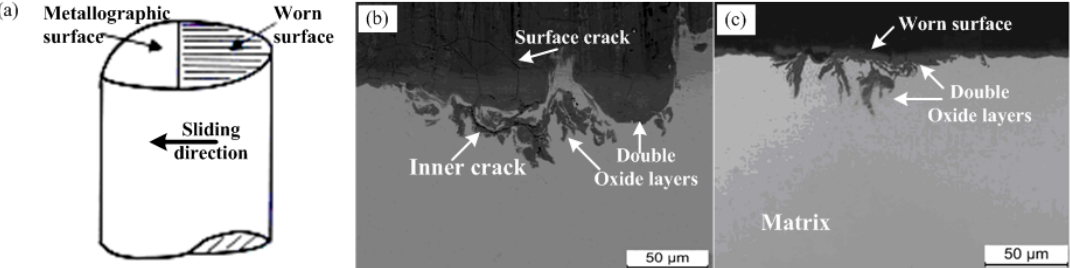
Figure 9. Section morphologies of worn surface of 18Ni(300) maraging steel under 300 N and 60 m / s: ( a ) schematic diagram of the clip section; ( b ) clip section morphology; and ( c ) cross section morphology.